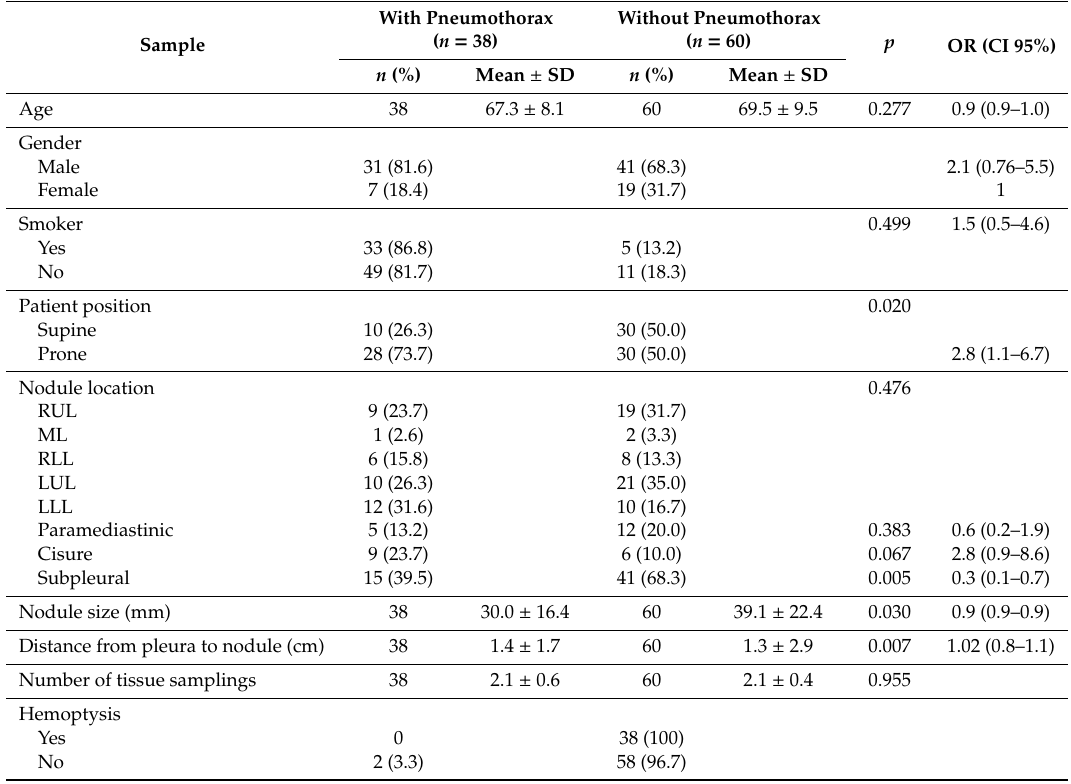
Table 2. Description of the sample according to the presence or absence of pneumothorax.